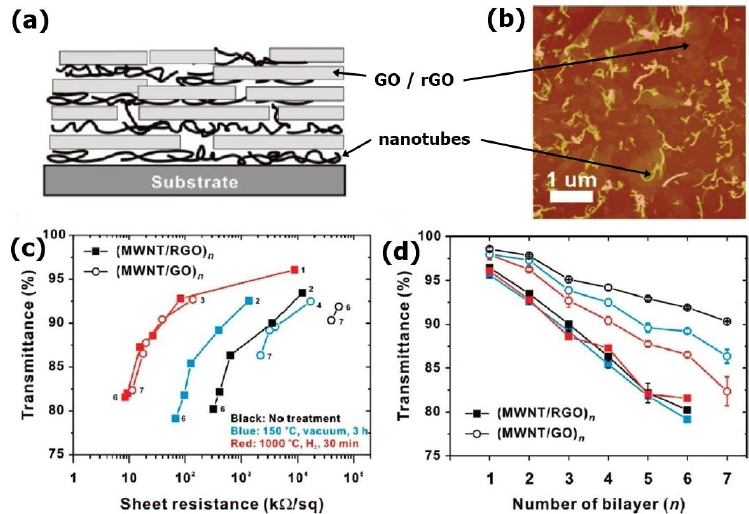
Figure 15. ( a ) Schematic illustration of the multi-layer electrode structure made from GO / rGO and multi-wall carbon nanotubes. ( b ) Atomic force microscopy image of the film surface morphology. One can see individual GO / rGO flakes as well as MWCNTs, and the surface roughness is about 10 nm on average. ( c ) The transmittance versus sheet resistance diagram shows a relatively high sheet resistance, which can be lowered by treatment processes. ( d ) The optical transmittance of the film electrode is quite high for a low number of bilayers, and it is comparable to ITO, but it naturally decreases with an increasing number of bilayers. (Reproduced by permission from